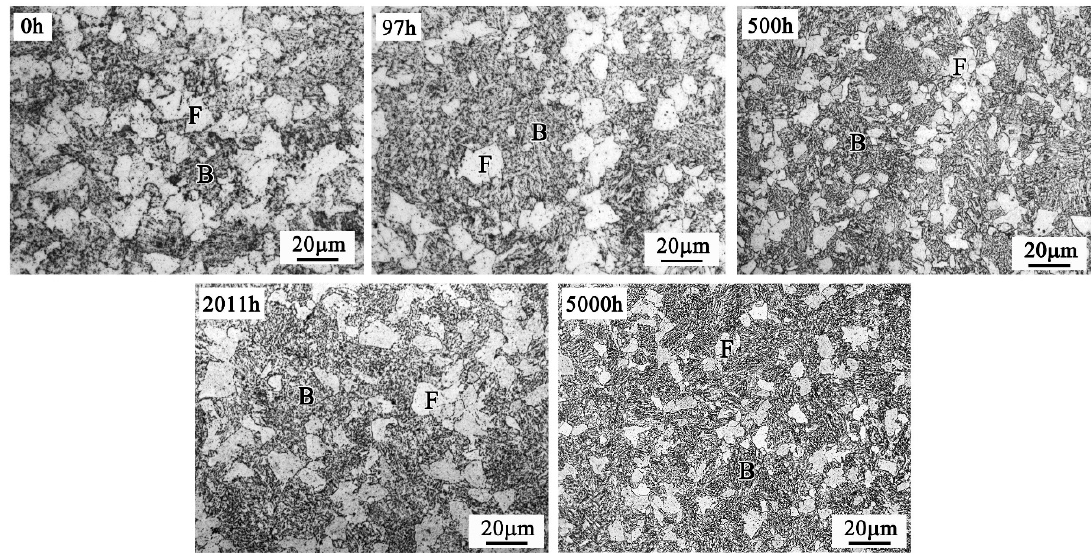
Figure 6. Microstructure and morphology of S2 experimental steel aging for different lengths of time at 580 °C.